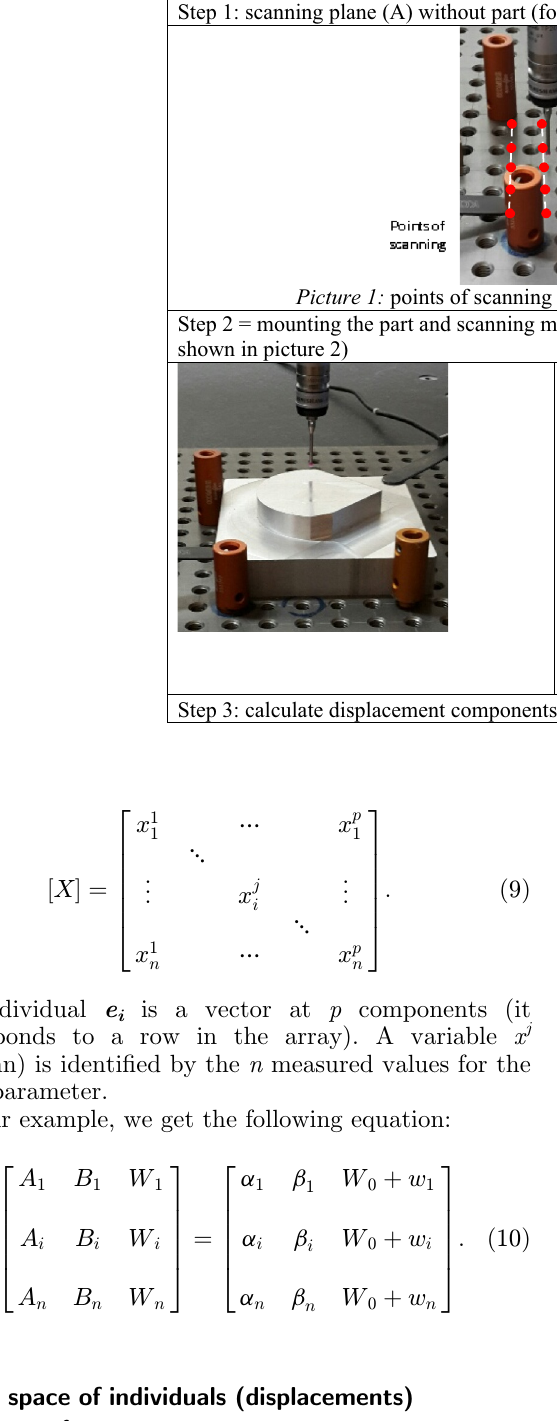
Table 1. Illustration of protocol measurement. Step 1: scanning plane (A) without part (following the strategy shown in picture 1)